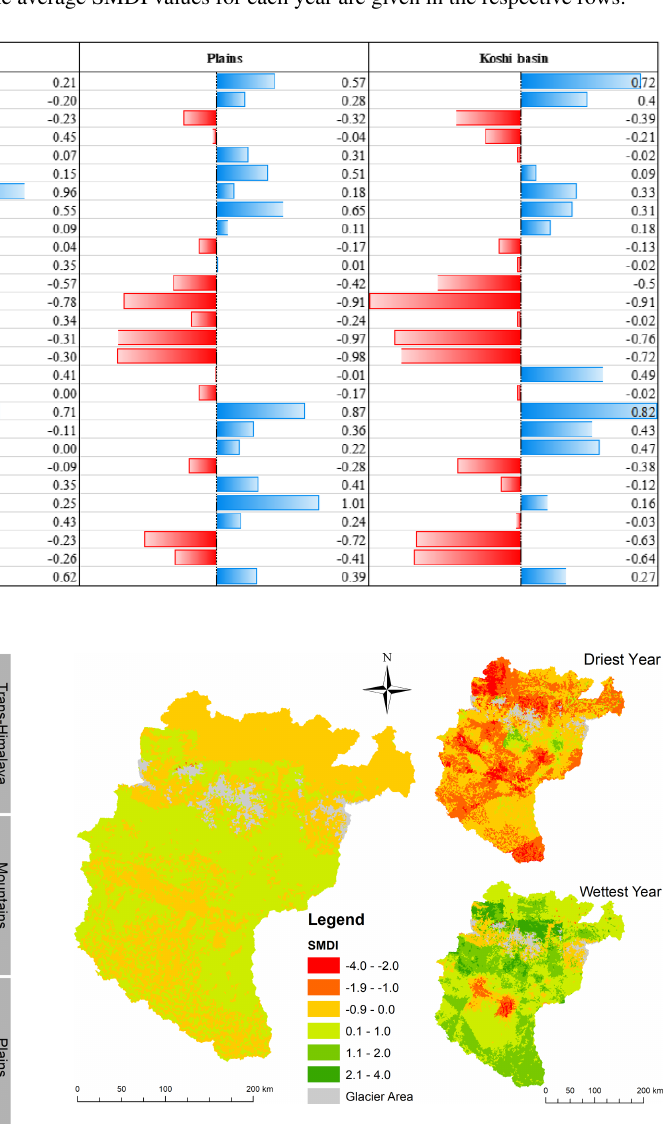
Figure 8. Spatial maps of the average annual SMDI (1980–2007), driest year (1992), and wettest year